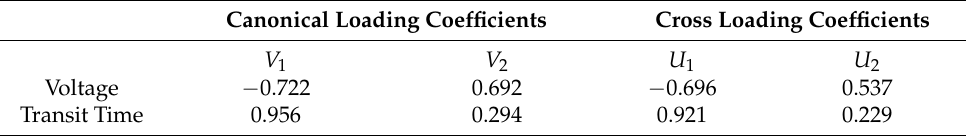
Table 6. Loading coefficients of output